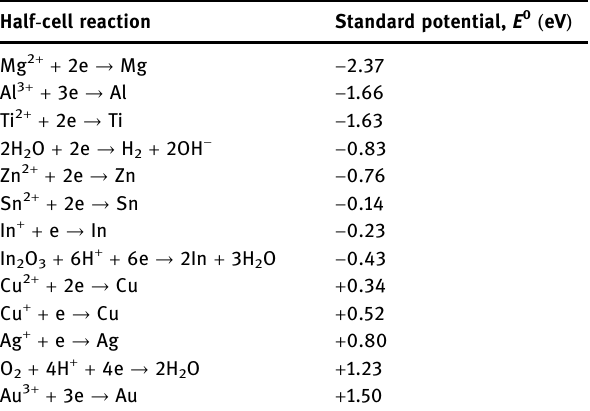
Half - cell reaction